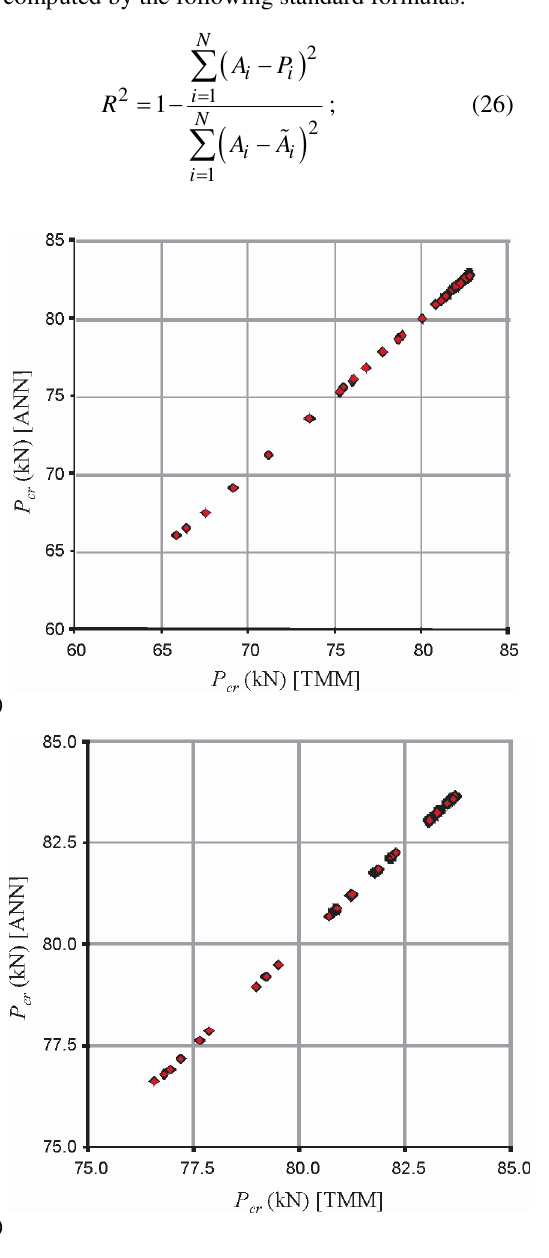
Fig. 6. The training performances of the models of: (a) fixed-free; (b) pinned-pinned; (c) fixed-pinned; and (d) fixed-fixed supported